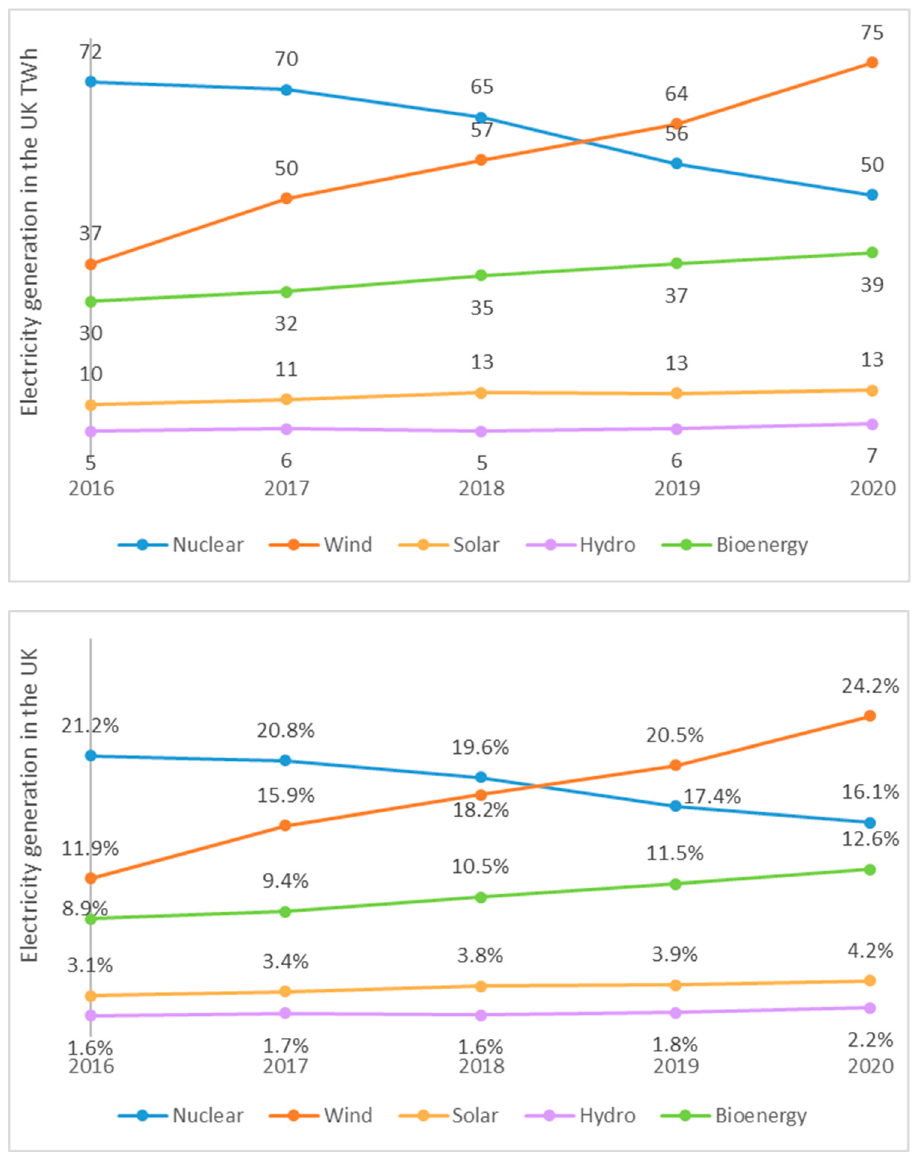
Figure 9. The UK electricity generation by alternative resource (both TWh ( top ) and percentage ( bottom ) per annum) from 2016 through to 2020 [2]. Table 2. The proportion of the UK electricity generation, present and forecasted, by resource [34].